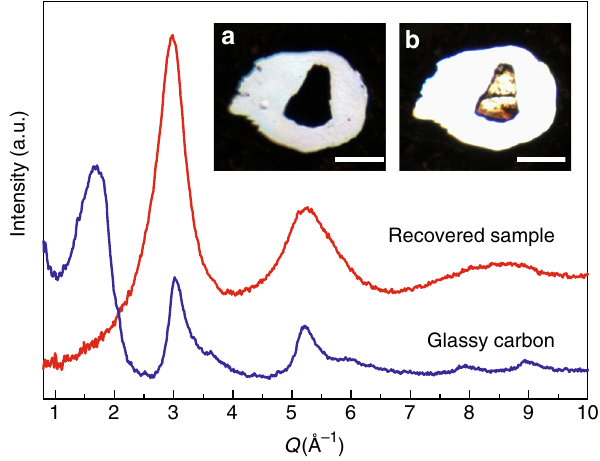
Fig. 1 Structure and image of the recovered sample. XRD patterns of the starting material glassy carbon ( blue ) and the sample recovered from high pressure and temperature ( red ). Inset a , Optical microscope image of the sample in the DAC at 49.6 GPa before laser heating showing the sample is opaque. Inset b , The sample becomes optically transparent after laser heating at the same pressure. The scale bars in insets represent 50 μ m. The sample size shrinks by approximately 3% in length and width, leading to an estimated volume decrease of nearly 10%, assuming the sample thickness also decreases by